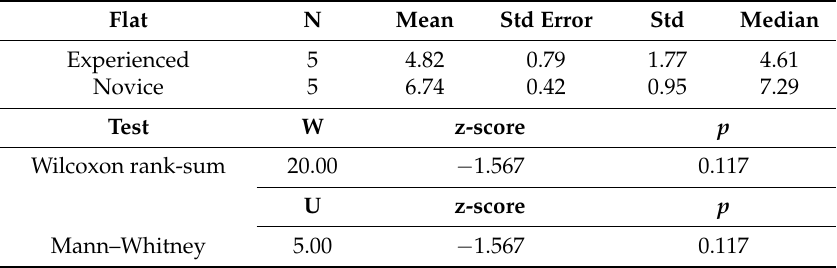
Table 10. Test for correlation between user skills level and task duration in skeuomorphic